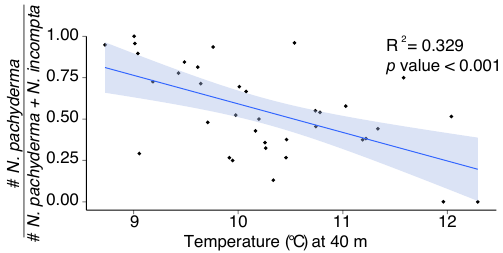
Figure 6. Ratio of N. pachyderma to N. pachyderma and N. in- compta at 40m depth with 95% confidence